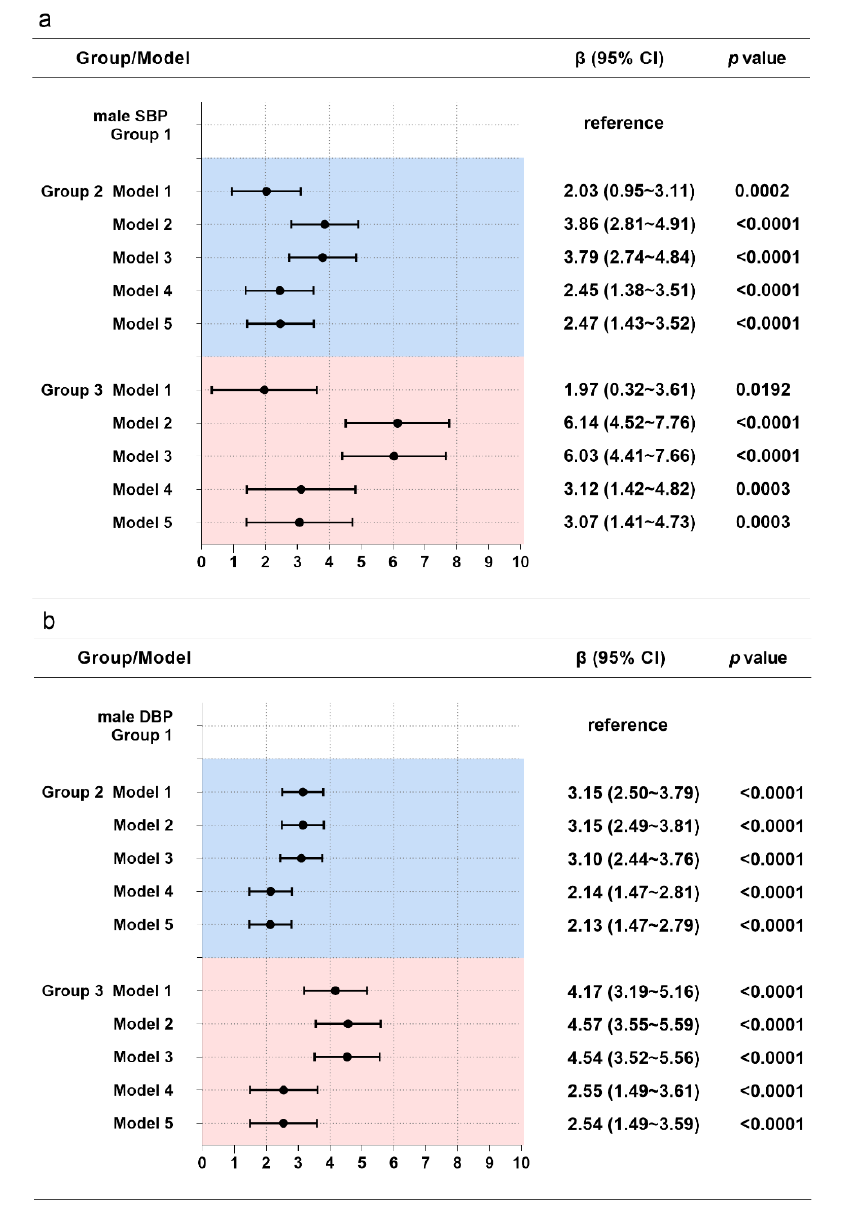
Figure 2. Associations between WC trajectories and SBP ( a ) and DBP ( b ) in males. Note: Model 1 adjusted for no covariates. Model 2 adjusted for age, educational level, geographic region (urban or rural), annual household income per capita, survey year, and follow-up time. Model 3 additionally adjusted for physical activity, current smoking status, current drinking status, Na intake, and K intake. Model 4 additionally adjusted for baseline BMI and WC. Model 5 additionally adjusted for baseline SBP and DBP.